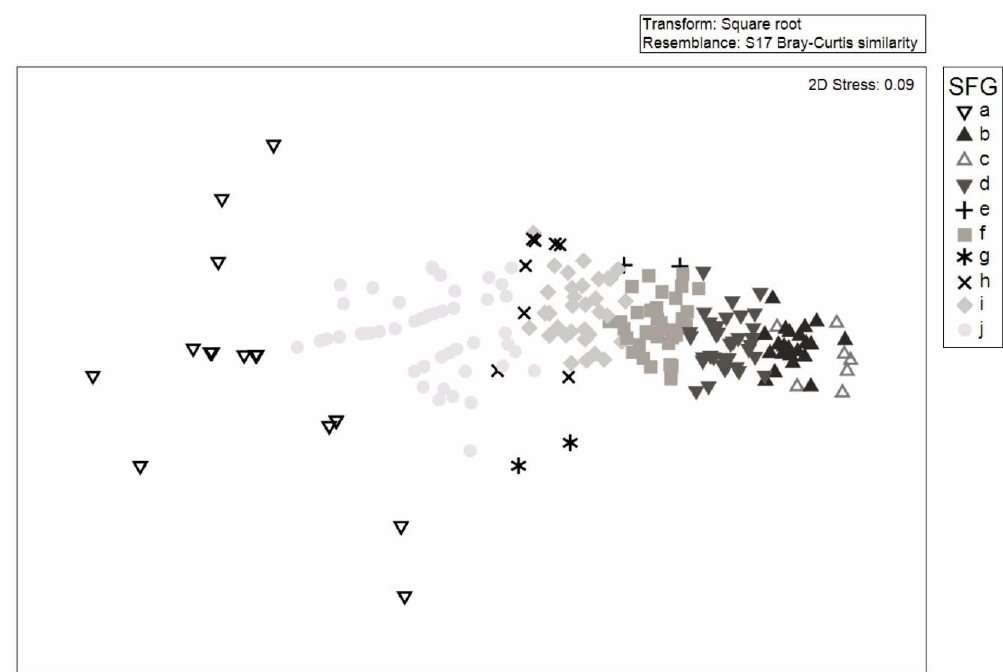
Figure 4. Non-metric multi-dimensional scaling (MDS) plot based on meiofauna similarity matrix. Significant SIMPROF-groups (SFG) are plotted as factors.